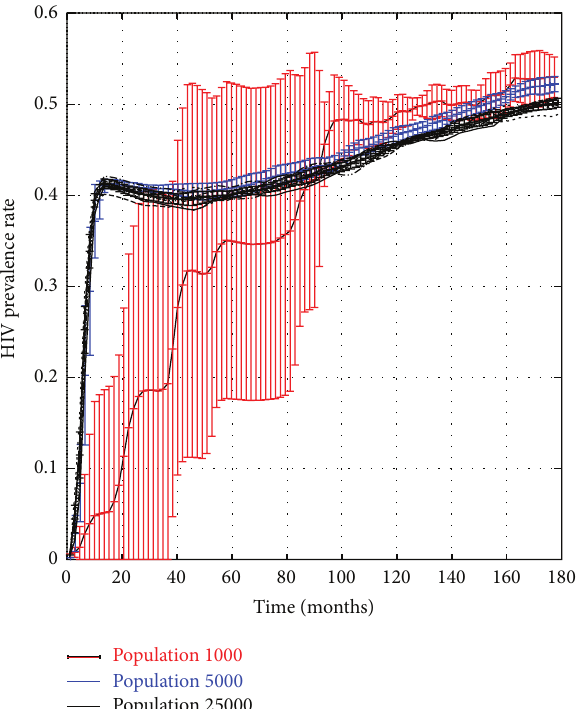
Figure 4: HIV rates in PWID networks of size 1k–25 k nodes.